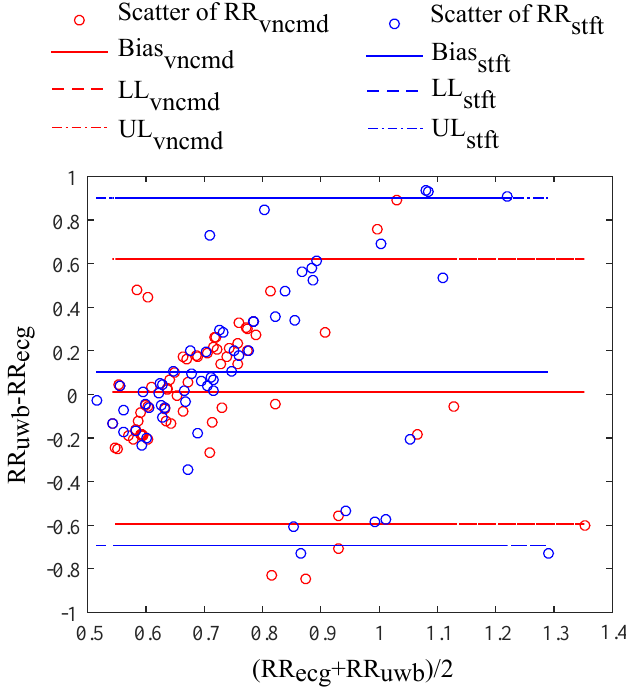
Figure 13. Scatters of R wave-to-R wave (RR) intervals in Bland–Altman